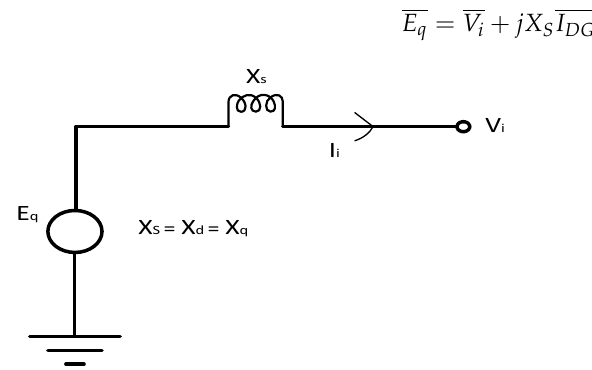
Figure 5. Steady State Model of Synchronous Machine.